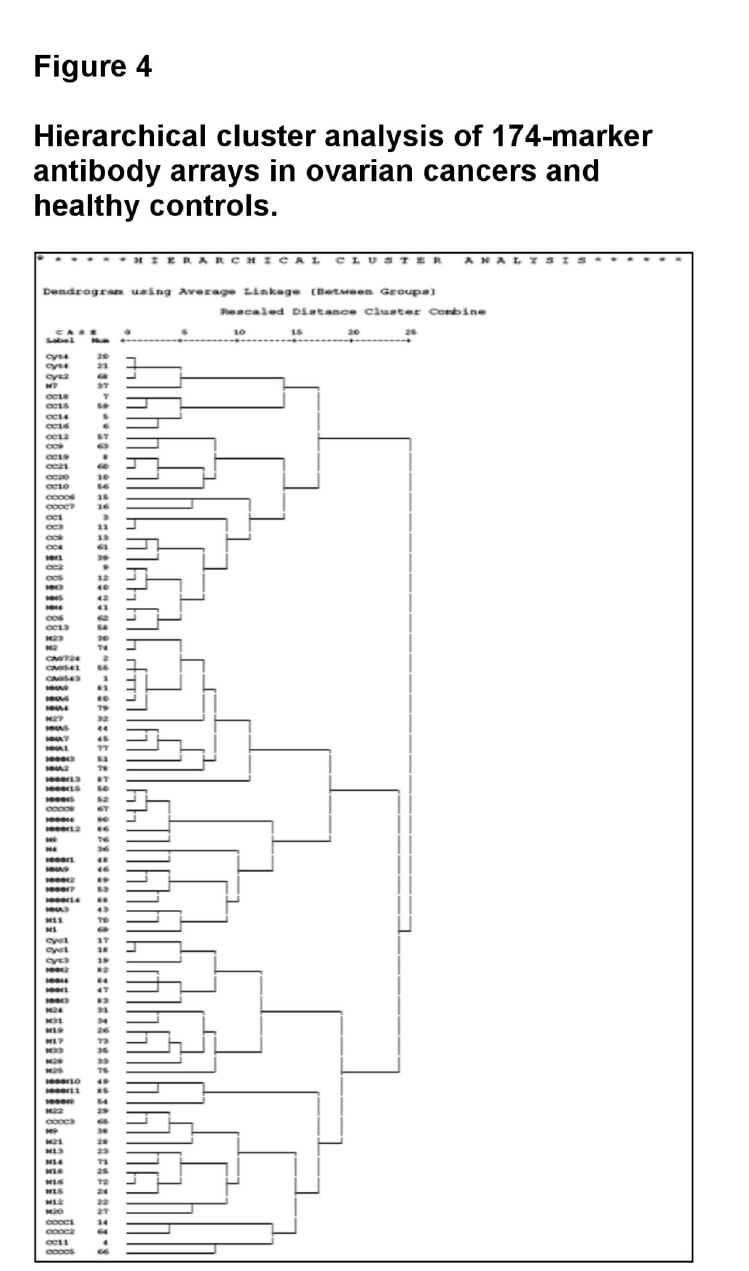
Figure 4. Hierarchical cluster analysis of 174-marker antibody arrays in ovarian cancers and healthy controls.